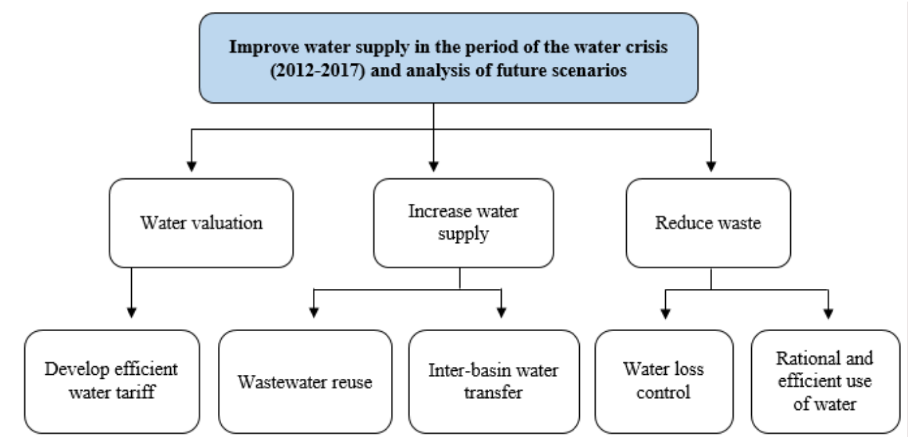
Figure 8. Tree of key stakeholder views.